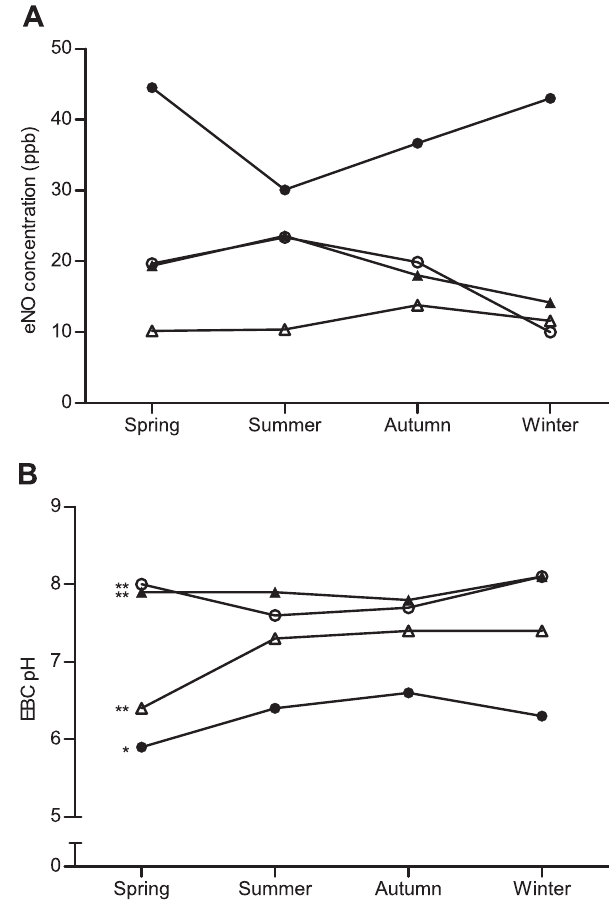
Figure 4. Seasonal variations of exhaled nitric oxide levels (A) and EBC pH values (B) in children. N : asthma group; # : allergic rhinitis group; m : AS + AR group; n : control group. *: p , 0.05; **: p , 0.01. (337.6 EU/mg dust in spring; 650.4 EU/mg dust in summer; 527.8 EU/mg dust in autumn; and 399.0 EU/mg dust in winter; p =0.015) and children with asthma and allergic rhinitis (446.0 EU/mg dust in spring; 913.5 EU/mg dust in summer; 541.0 EU/mg dust in autumn; and 390.2 EU/mg dust in winter; p , 0.01; Fig. 2).